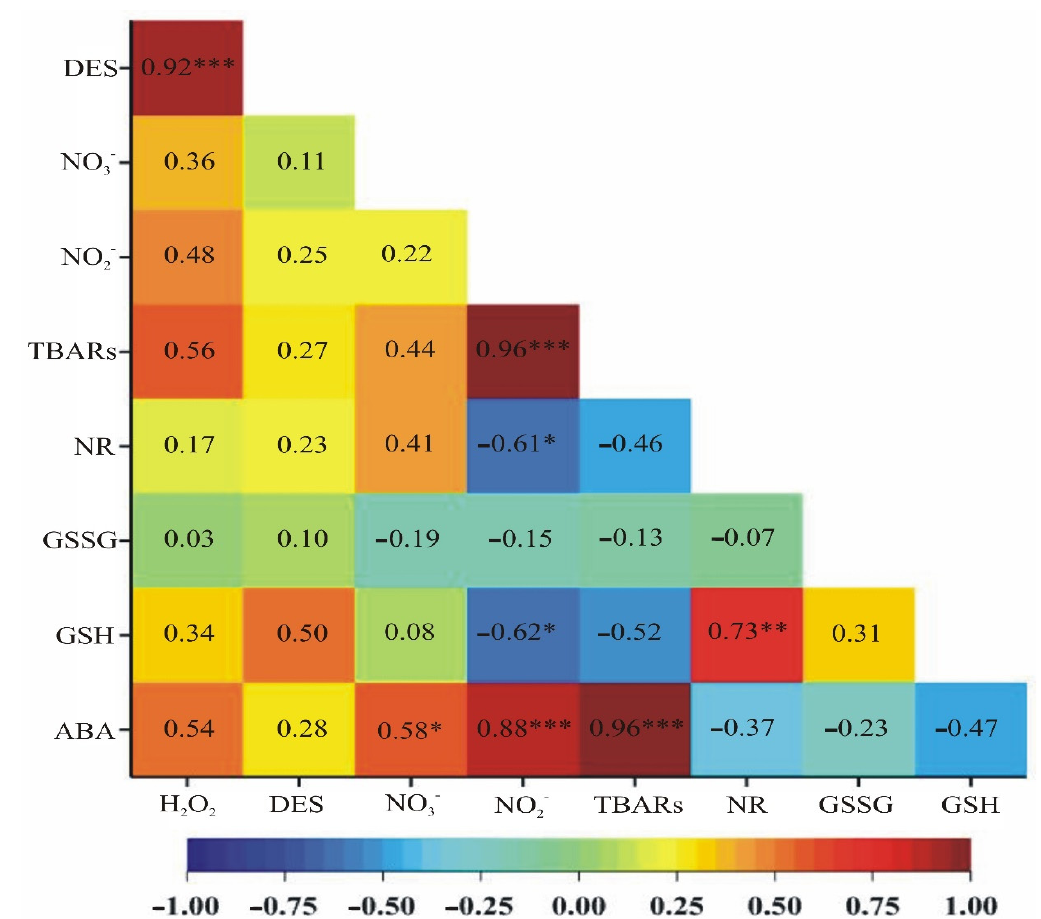
Figure 6. A heat map showing correlation coefficients between ABA, GSH, GSSG, TBARS, H 2 O 2 , NO 3 − , NO 2 − contents and DES and NR activities. ***—a significance level of α = 0.001, **—a significance level of α = 0.01, *—a significance level of α = 0.05.